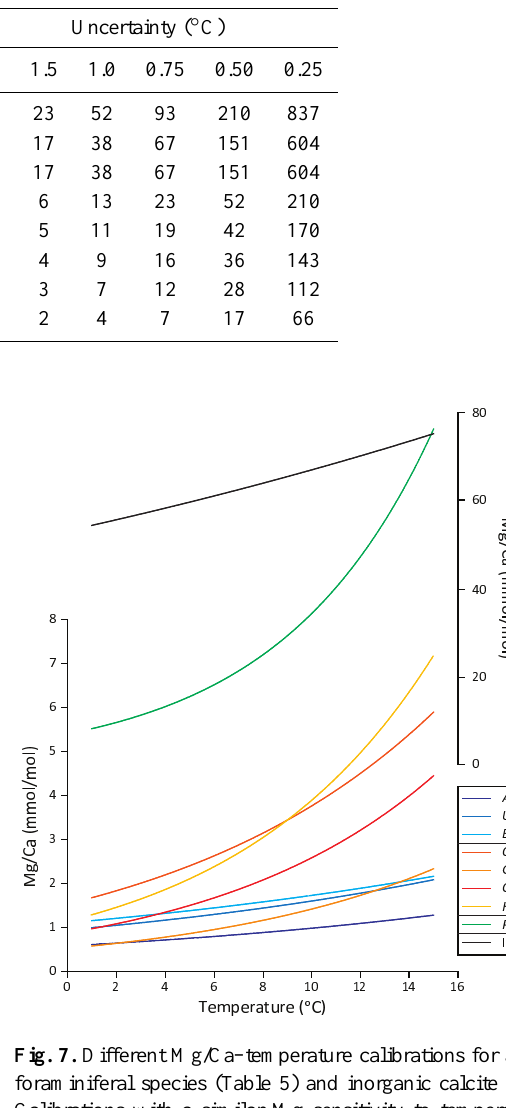
Table 5. Number of individuals needed to obtain a given uncertainty in temperature, based on the sensitivity of a Mg/Ca–temperature calibration and the averaged standard deviation of 16.3%. Uncertainty is expressed as a range (max–min) around the average reconstructed temperature. (1) This study, (2) Toyofuku et al. (2011), (3) Elderfield et al. (2006), (4) Rathmann et al. (2004), (5) Anand et al. (2003), (6) Lear et al. (2002), (7) Rosenthal et al. (2011), (8) Wit et al. (2012).